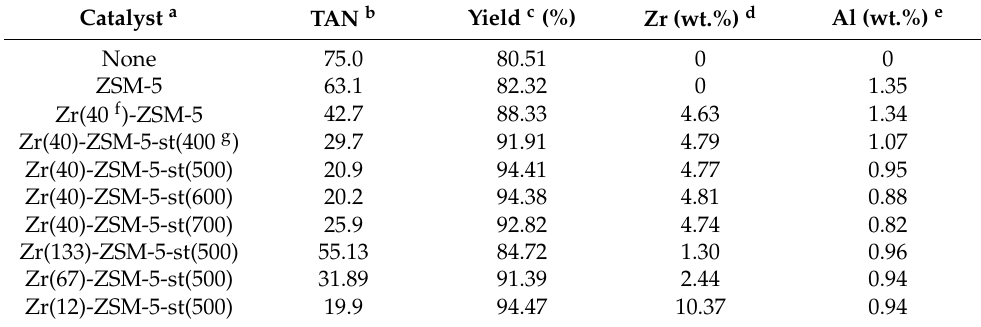
Table 1. Catalytic activities for ZSM-5, Zr-ZSM-5 as well as various Zr-ZSM-5-st catalysts for lubricat- ing ester synthesis